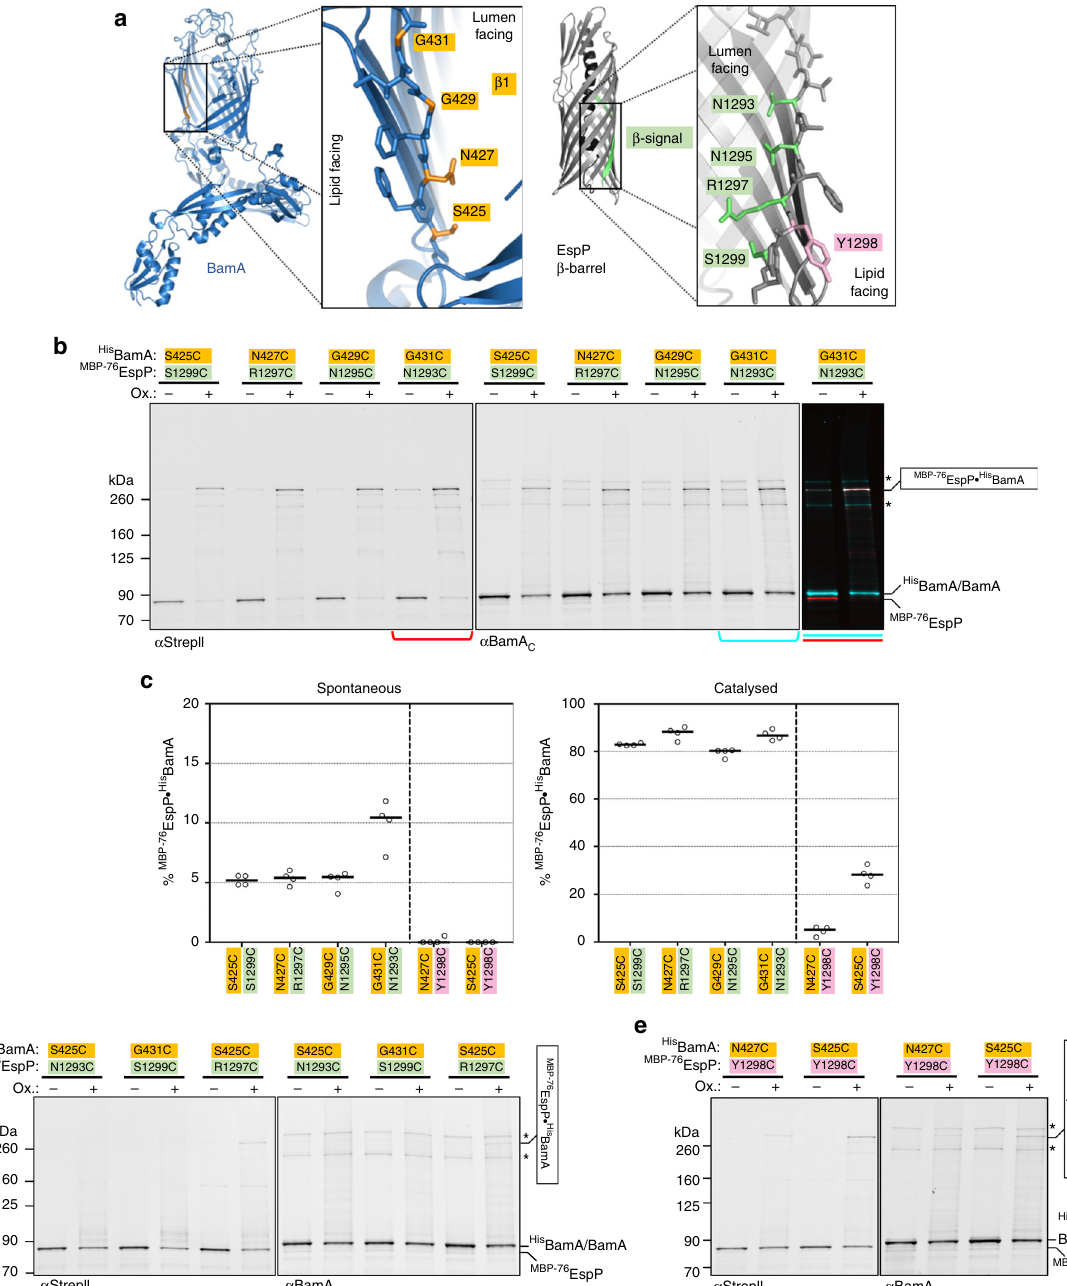
Fig. 2 During assembly the MBP − 76 EspP( β 1) β -signal forms a stable antiparallel seam with BamA( β 1). a Luminal residues in BamA( β 1) (orange), and luminal and lipid-facing residues in MBP − 76 EspP( β 12) (green and pink, respectively) are shown. Foreground strands of the MBP − 76 EspP β -barrel are transparent in the zoom box. The ‘ luminal ’ and ‘ lipid-facing ’ designations are based on the orientation of the residues in solved structures (5ljo, 5d0o, and 3slj) 20,21,42 . The BamA and EspP residue numbers are based on their position in the native protein sequence. b BL21(DE3) that expressed MBP − 76 EspP with single cysteine substitutions at a luminal positions in β 12 and His BamABCDE with cysteine substitutions at a lumen-facing positions in His BamA( β 1) were mock-treated ( − ) or treated with 4-DPS ( + ). Duplex-immunoblots were then conducted using antibodies/antisera against the N-terminus of MBP − 76 EspP ( α StrepII, red) and the C-terminus of His BamA/BamA ( α BamA C , cyan) to monitor disul fi de-bond formation between cysteine pairs in vivo. The signals are overlaid for one pair ( MBP − 76 EspP N1293C / His BamA G431C , right). Non-speci fi c bands are denoted (*). c Quantitation of disul fi de-bond formation between MBP − 76 EspP ( β 12)- His BamA( β 1) cysteine pairs. Experiments were performed as in b , e (see below) except that only α StrepII was used for probing immunoblots in mock- treated ( ‘ spontaneous ’ ) and 4-DPS-treated cells ( ‘ catalysed ’ ). Bars = median, N = 4. ANOVA and multiple comparison tests are shown in Supplementary Table 1. d The experiments shown in b were repeated, except that misaligned lumen-facing cysteine pairs in His BamA( β 1) and MBP − 76 EspP( β 12) were analysed. e The experiments shown in b were repeated, except that lumen-facing cysteine positions in His BamA( β 1) and lipid-facing cysteine positions in MBP − 76 EspP( β 12) were analysed. Data are representative of at least two independent experiments for b , d and e . Source data are provided as a Source Data fi